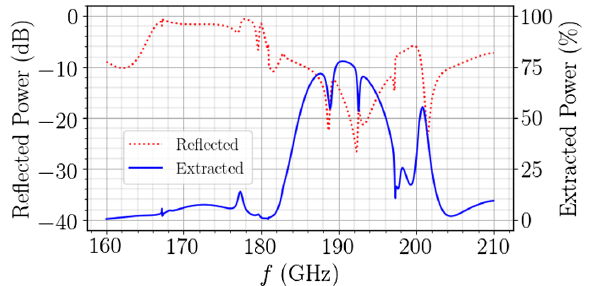
FIG. 8. TE 11 extraction and reflection from the transition section including the TM 01 coupler before the IOM.